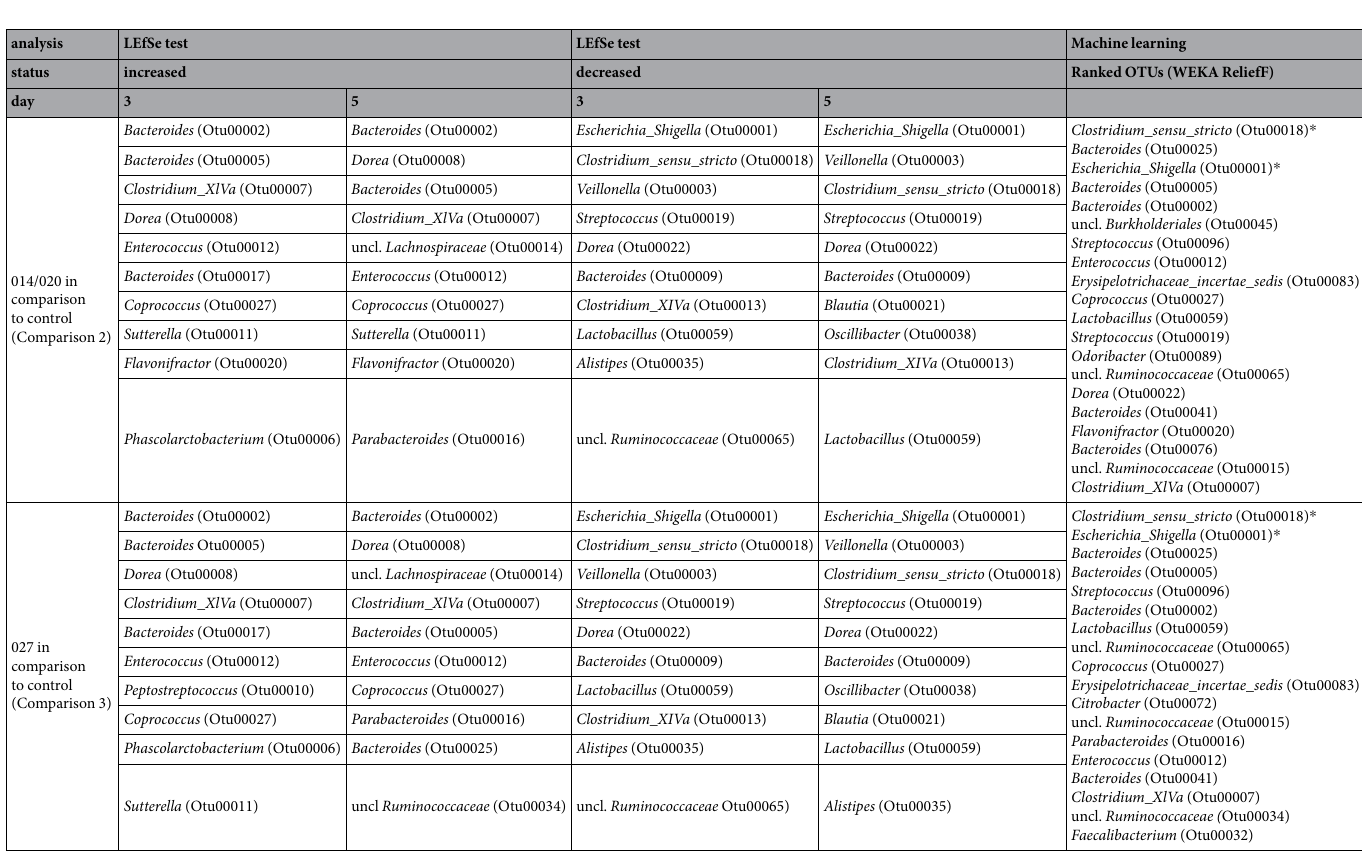
Table 1. Differentially represented OTUs identified by the LEfSe test (mothur software) and machine learning approaches (WEKA ReliefF). Uncl. = unclassified. LEfSe uses linear discriminant analysis (LDA) to find OTUs that significantly differ in abundance between control and C. difficile samples. Only top 10 OTUs with highest LDA scores are presented, for additional information see Table S2 in Supplementary Information. Additional information can be extracted from the WEKA ReliefF rankings of OTUs in terms of their relevance for distinguishing between control and different ribotype C. difficile samples. Top 20 ranked OTUs are shown in the rightmost column (taken from Figure